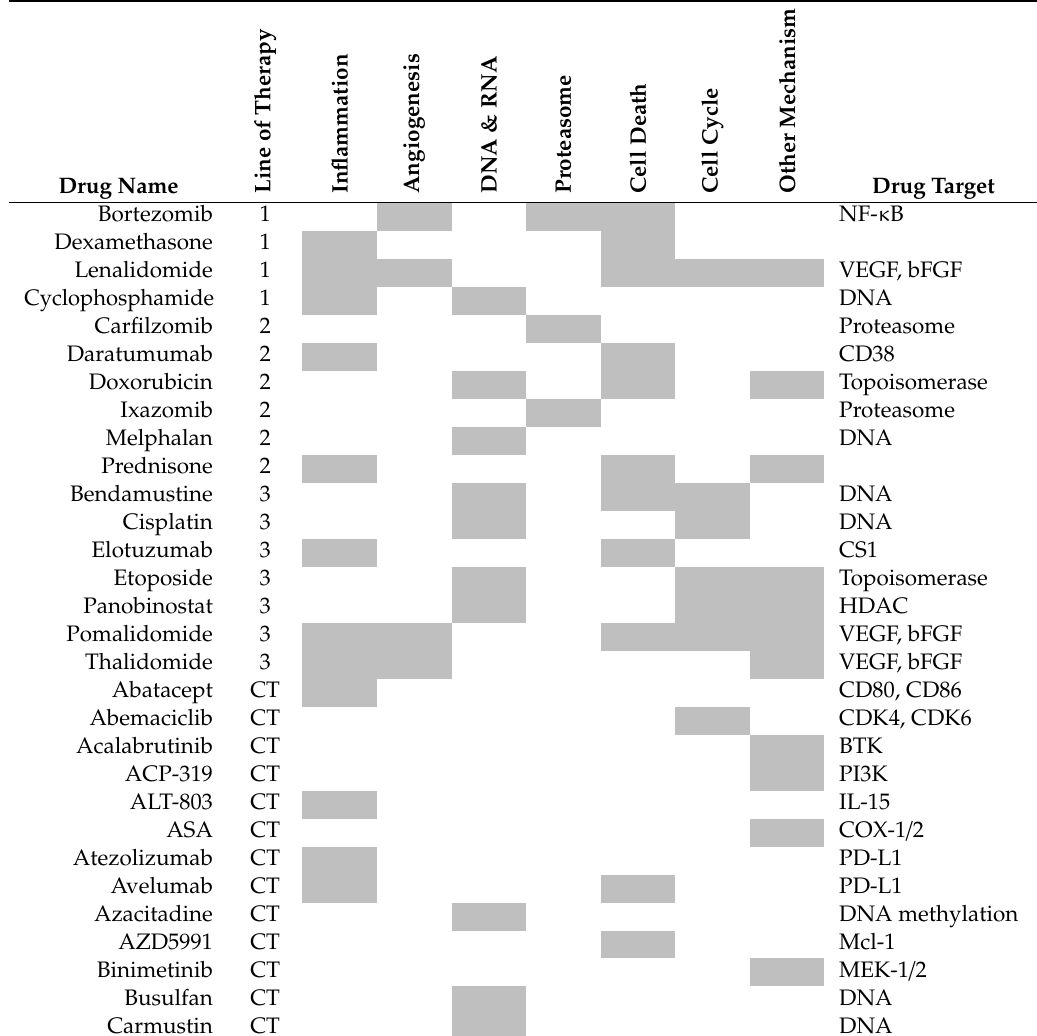
Table 1. Summary of anti-MM drug